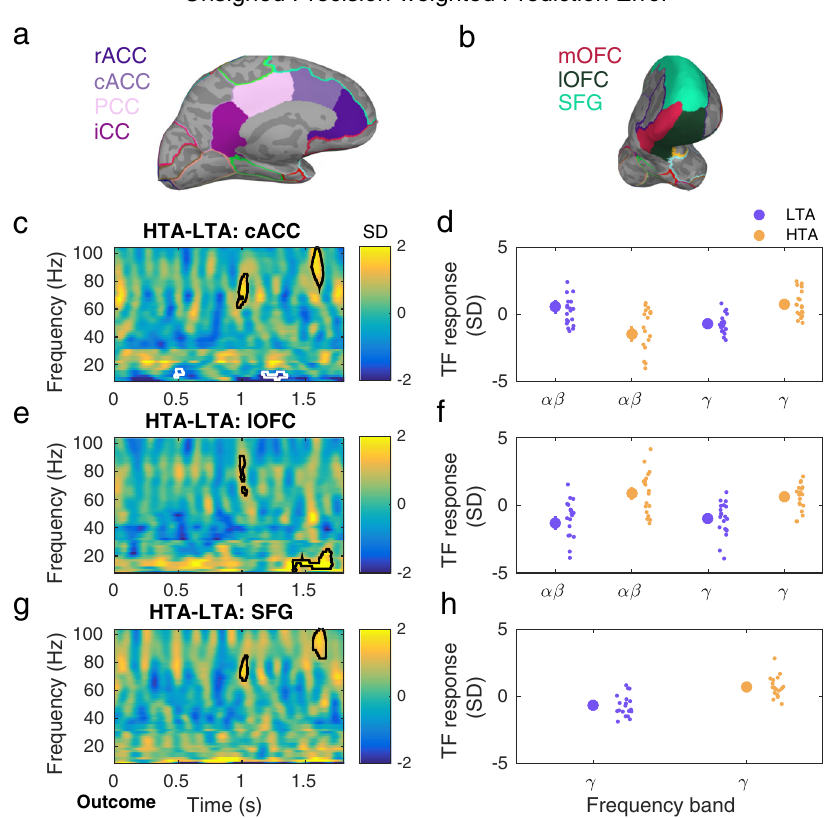
Fig. 3 Gamma activity is modulated by unsigned precision-weighted prediction errors about stimulus outcomes and is enhanced with high trait anxiety. a , b Source reconstruction of MEG signals was carried out with linearly constrained minimum norm variance (LCMV) beamforming. The statistical analysis of the convolution GLM results focused on brain regions that overlap with the circuitry of anxiety and decision making under uncertainty: ACC, OFC (lateral and medial portions: lOFC, mOFC), SFG. Panels a and b illustrate the corresponding anatomical labels in the neuroanatomical Desikan- Killiany – Tourville atlas (DKT), which we chose to parcellate each participant ’ s cerebral cortex using the individual T1-weighted MRI. Panels c , e , f display between-group differences in the time-frequency (TF) images that summarise the individual oscillatory responses to the unsigned precision-weighted PEs about stimulus outcomes. TF images are shown in the 8 – 100 Hz range, including alpha (8 – 12 Hz), beta (14 – 30 Hz) and gamma (32 – 100 Hz) activity. TF images were normalised with the mean and standard deviation (SD) of the activity in a [ − 300, − 50] ms pre-outcome interval, and thus are given in SD units. Convolution modelling and TF transformation were conducted in the range 8 – 120 Hz in frequency bands of 2 Hz, following LCMV beamforming. c In the cACC, high relative to low trait anxiety was associated with greater gamma responses at ~1 and 1.6 s during outcome feedback processing (cluster- based permutation testing, two clusters, P = 0.001, FWER-controlled; N = 19 HTA and 20 LTA independent samples). Signi fi cant between-group effects are denoted by the black and white contour lines in the TF images. The gamma-band effects were accompanied by a decrease in alpha-beta activity (10 – 16 Hz) in HTA as compared to LTA individuals, and at ~0.5 and 1.3 s (cluster-based permutation testing, P = 0.01 and 0.008, FWER-controlled). d The relative gamma increase in HTA shown in c) was due to more positive gamma activity during encoding unsigned pwPE in HTA than in LTA. On the other hand, HTA individuals exhibited a negative change in 10 – 16 Hz responses, in contrast to the positive alpha and beta activity observed in LTA individuals. This resulted in the negative between-group effect in 10 – 16 Hz activity in ( c ). The large circles represent the mean (and SEM) TF response in the signi fi cant spectrotemporal clusters in c), shown separately for low frequency (alpha, beta) and gamma activity, and for each group (LTA: purple; HTA: yellow). Individual dots represent individual participant average values. e , f Same as c , d but in the lOFC. Signi fi cant clusters in 10 – 22 Hz and gamma ( P = 0.008 and 0.005, respectively, FWER-controlled). g , h Same as c , d but in the SFG. Signi fi cant clusters in gamma frequencies ( P = 0.001,